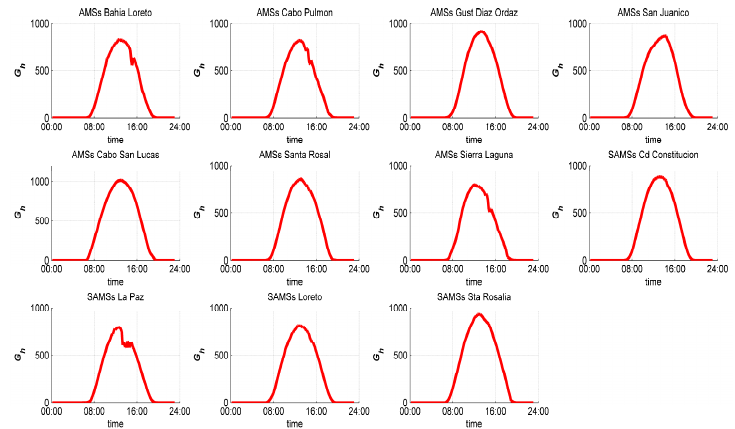
Figure 7. Daily irradiance patterns registered in Baja California.